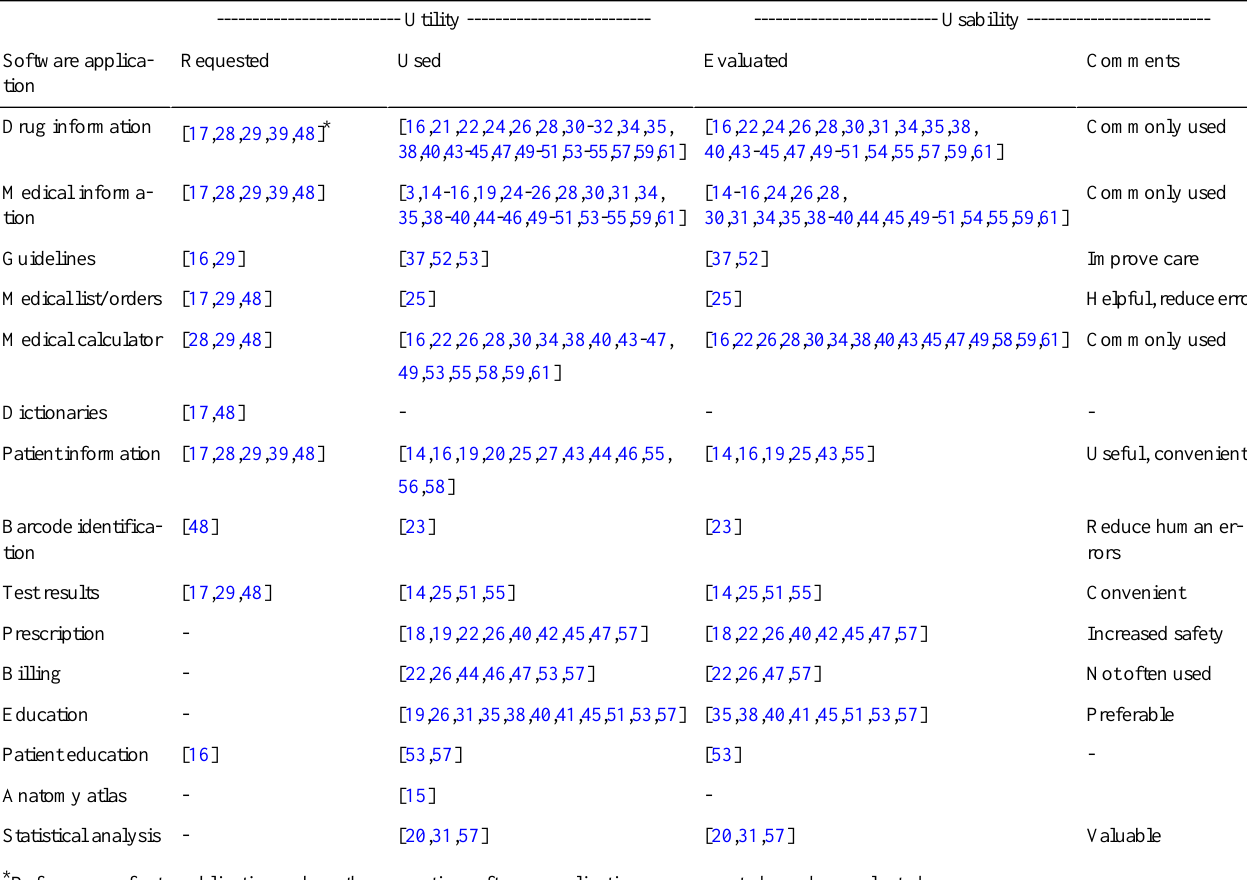
Table 5. Reported usefulness as usability and utility for software applications on the